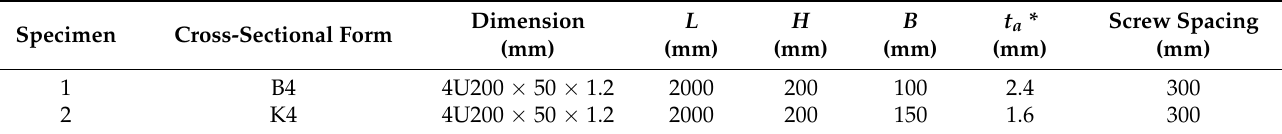
Figure 1. Schematic of members and specimens. ( a ) U-shaped CFS; ( b ) B4 cross section; ( c ) K4 cross section (Unit: mm).